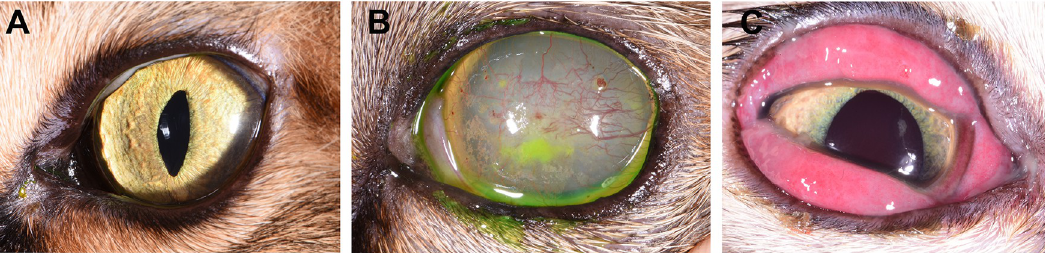
Fig 4. Typical lesions associated with ocular infection with the feline herpesvirus FHV-1 in naturally infected cats. Photographs depict signs of infection in naturally infected cats: A) healthy cat eye; B) severe corneal inflammation and resulting keratitis, and C) conjunctivitis with significant hyperemia and